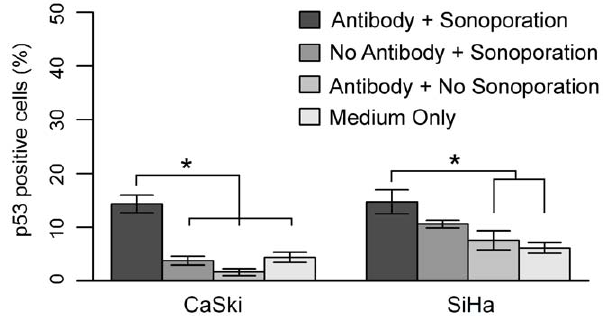
Figure 10. p53 positive cells (%) following the intracellular delivery of the F127-6G6 E6 antibody via sonoporation. After 48 hours, the three-way interaction between cell type, sonoporation, and antibody was significant ( P= 0.008). CaSki cells receiving 4 m g/mL of the F127-6G6 E6 antibody coupled with sonoporation (Sono) had a greater number of p53 positive cells than those in the three control groups ( P , 0.001 for all 3 comparisons, n =6 for all). SiHa cells receiving 4 m g/ mL of the F127-6G6 E6 antibody coupled with sonoporation had a greater number of p53 positive cells than those in the groups receiving the antibody only or no antibody and no sonoporation ( P= 0.012, P= 0.001 respectively, n= 6 for both). Sonoporation alone resulted in a significantly higher number of p53 positive cells in SiHa than CaSki ( P= 0.019, n= 6). Statistical analysis was performed using a three-way ANOVA followed by Tukey HSD contrast tests post hoc. Error bars represent mean + / 2 SEM. ‘‘*’’ denotes significance.